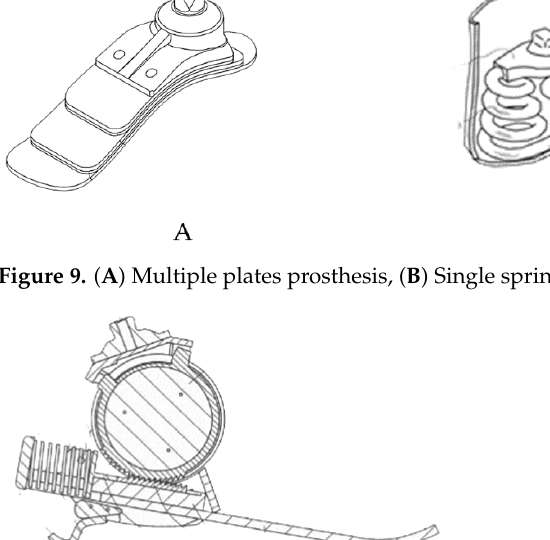
Figure 10. CERS prosthesis by Endo Ken [129].